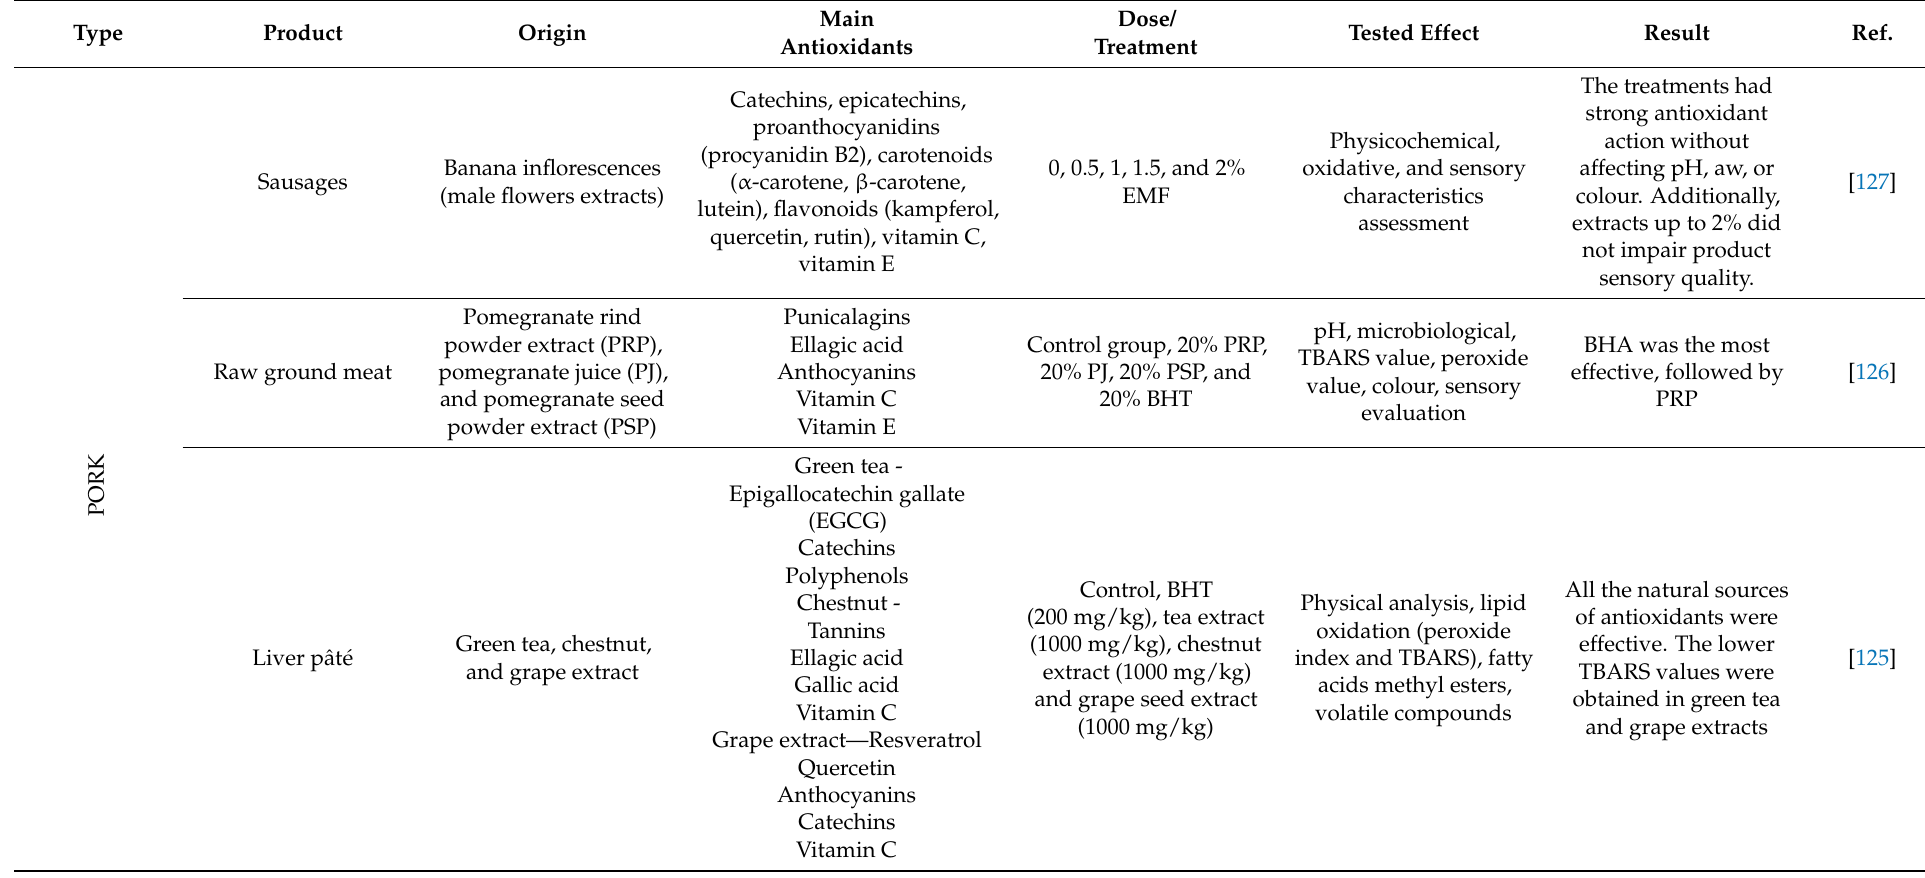
Table 6. Literature review on the effects of some natural antioxidant sources in meat